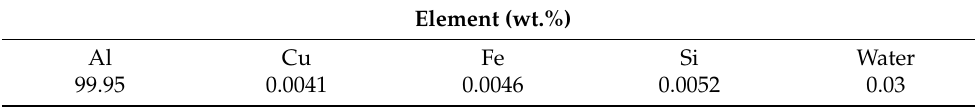
Table 1. Main components of the pure aluminum.